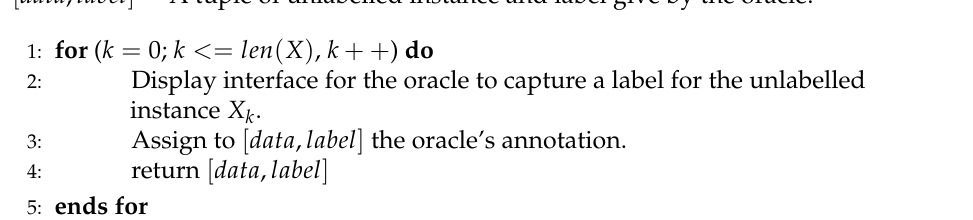
Algorithm 6 Request for annotating unlabelled data to the